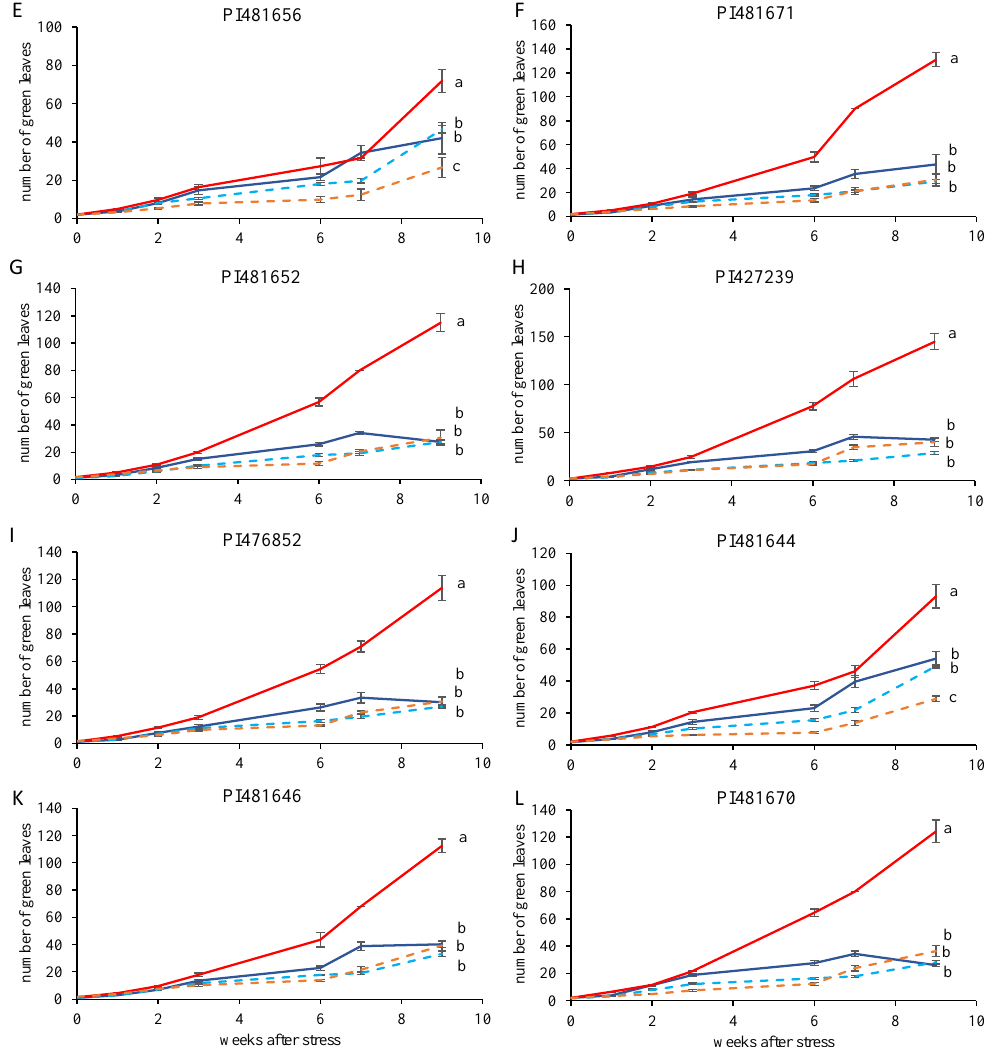
Figure 2. Leaf production of F. tataricum varieties subjected to two temperatures (21 °C vs. 28 °C) and water supply conditions (well-watered vs. water-stressed). Varieties ( A ) Islek, ( B ) Zlata, ( C ) Lifago, ( D ) PI481659, ( E ) PI481656, ( F ) PI481671, ( G ) PI481652, ( H ) PI427239, ( I ) PI476852, ( J ) PI481644, ( K ) PI481646, and (L ) PI481670. 21WW: 21 °C well-watered, 21WS: 21 °C water stress, 28WW: 28 °C well-watered, 28WS: 28 °C water stress. Values followed by a same letter for the same variety were not statistically significant at the 5% level at the end of the experiment.